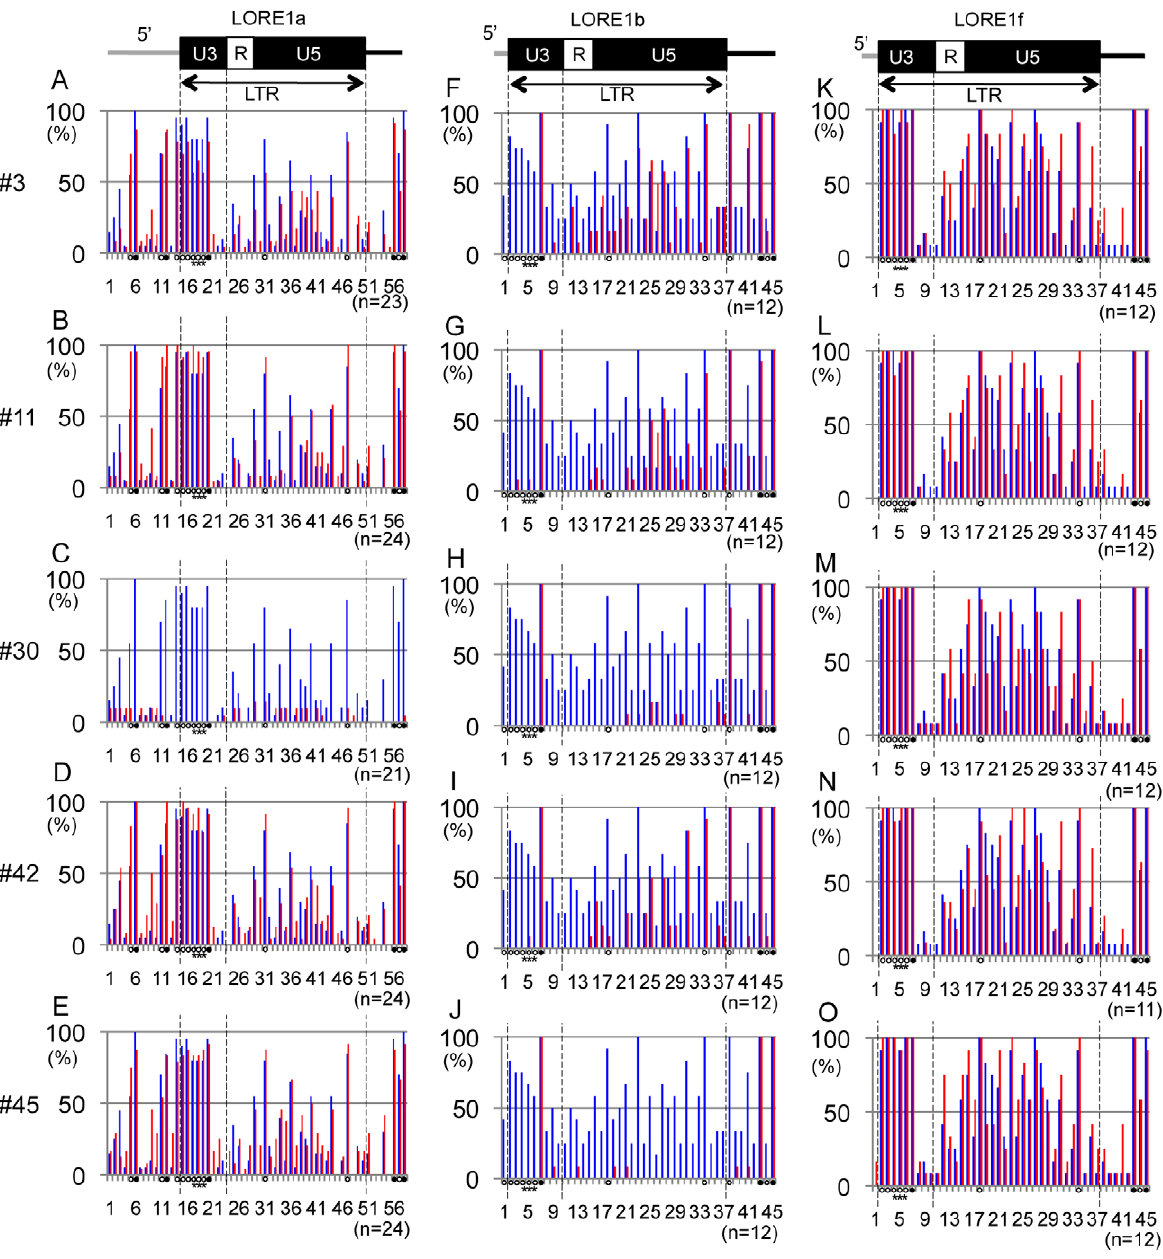
Figure 6. Cytosine methylation status around the 5 9 LTR of LORE1 a, LORE1 b, and LORE1 f. Bar graphs showing percentage of methylation at 58, 45, and 45 cytosines in the genomic regions around the 5 9 LTR of LORE1 a (A–E), LORE1 b (F–J), and LORE1 f (K–O), respectively. Methylation status in the Gifu control is represented by blue bars, while red bars indicate status in T0 plants. The positions of the 5 9 flanking region, the 5 9 LTR, and a part of the internal region of each LORE1 locus were analyzed and are shown at the top. Regions correspond to LTRs and U3 regions are indicated with dotted lines. Closed and open circles correspond to the cytosines in CG and CHG contexts, respectively. Cytosines without any marks are present as CHH. Asterisks indicate cytosines in Alu I sites in the LTRs. The numbers of the sequenced TA clones are indicated at the bottom right of each bar